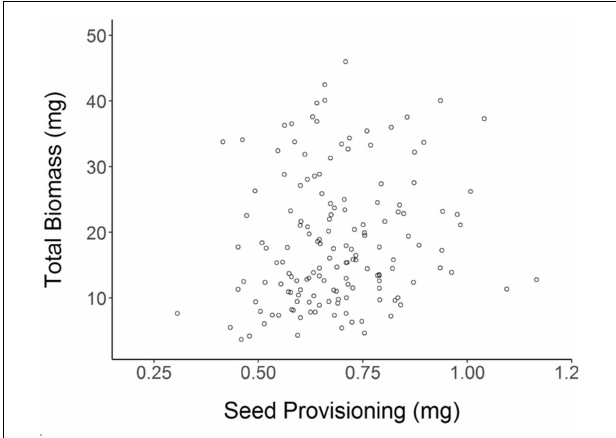
FIGURE 5 | Total biomass of each (day 20) seedling as a function of its initial seed provisioning ( R 2 adj = 0.0154 n.s., N = 152; details in section “Materials and